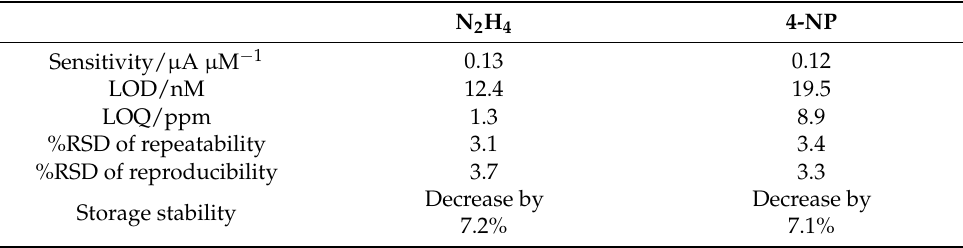
Figure 3. DPVs ( A , B ) and corresponding calibration plots ( C , D ) of N 2 H 4 ( A , C ) and 4-NP ( B , D ) between 20–1200 µ M, in 0.1 M PBS buffer (pH 7.4) at the AuNPs/PCA-rGO/SPCEs, with 0.05 s modulation time, 0.2 s interval time, 60 mV modulation amplitude, 10.5 mV step potential, and 50 mV s − 1 scan rate. Table 1. Sensitivity (S), limit of detection (LOD), limit of quantification (LOQ), and %RSD of repeata- bility and reproducibility and storage stability of the AuNPs/PCA-rGO/SPCEs towards 0.6 mM N 2 H 4 and 0.6 mM 4-NP,